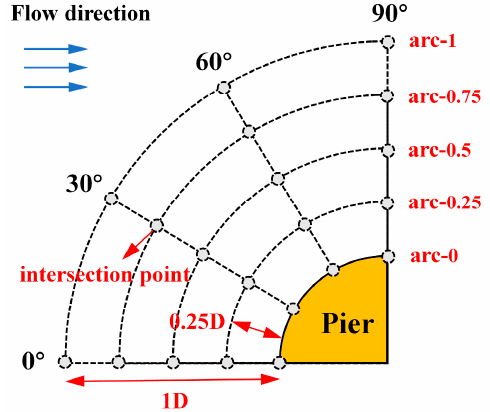
Figure 7. Distribution of measuring points around the pier.